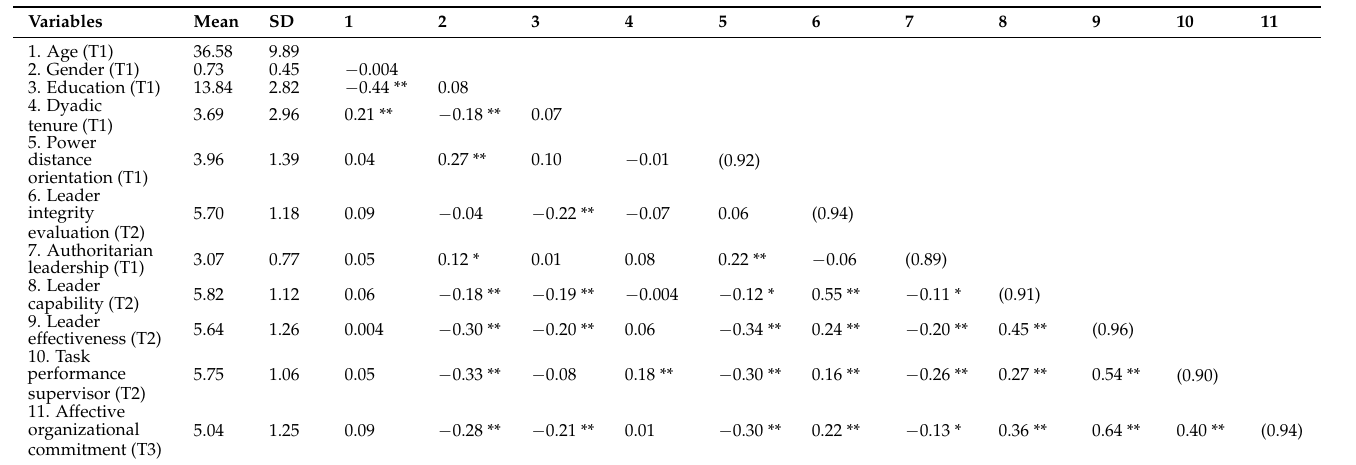
Table 1. Descriptive analysis.